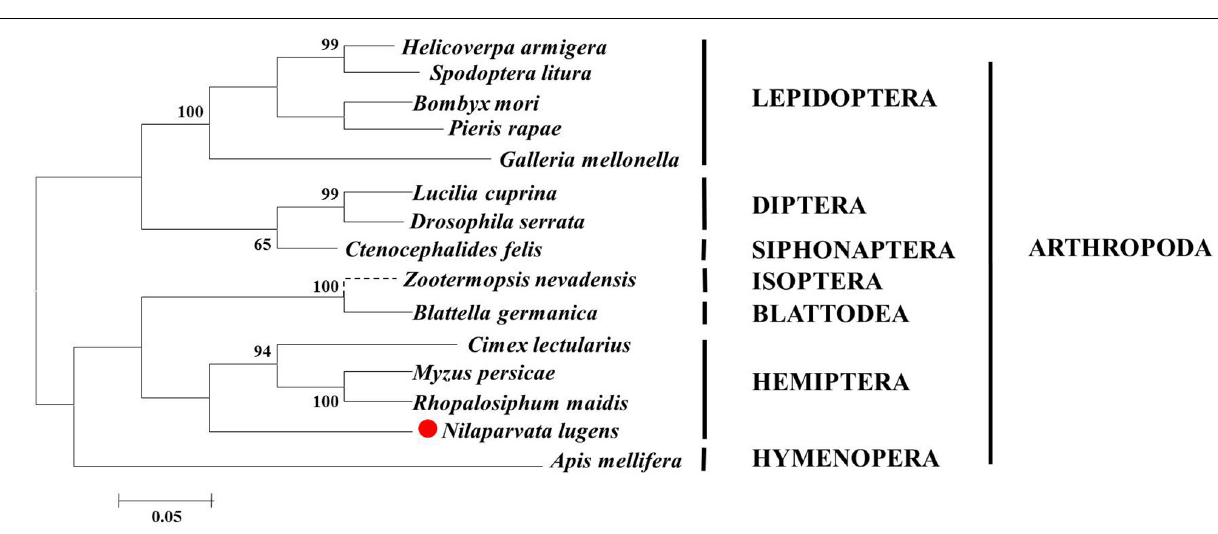
FIGURE 2 | Phylogenetic analysis, based on amino acid sequences, of the SPF-L sequences from BPH and other insects. Sequences were retrieved from GenBank protein database, including Helicoverpa armigera (XP021184618), Zootermopsis nevadensis (XP021941207), C. lectularius (XP014242913), Blattella germanica (PSN58039), Bombyx mori (XP004927858), Spodoptera litura (XP022829415), Pieris rapae (XP022120009), Myzus persicae (XP022167433), Rhopalosiphum maidis (XP026813571), Apis mellifera (XP394140), Lucilia cuprina (XP023302715), Ctenocephalides felis (XP026461767), Drosophila serrata (XP020809590), and Nilaparvata lugens (XP022194947). The phylogentic tree of SPF-L homologs was constructed using the Maximum Likelihood method with MEGA6 software. Bootstrap values are shown in the nodes. Branch lengths are proportional to sequence divergence. The scale bar indicates the average number of amino acid substitutions per